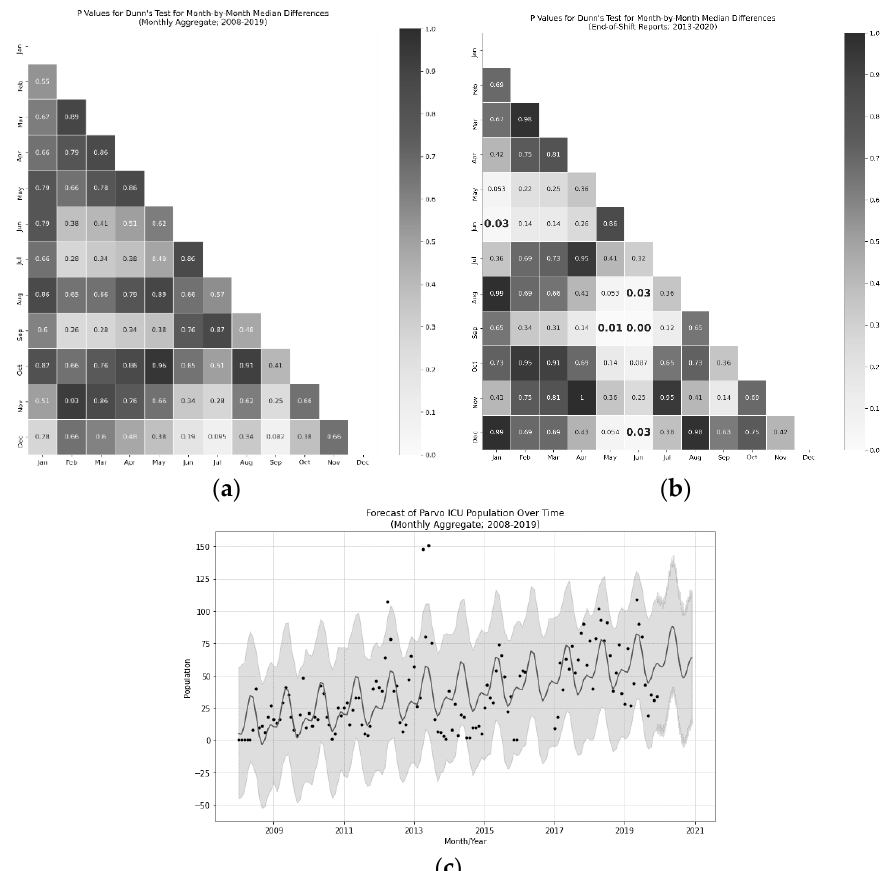
Figure 4. Heatmaps ( a and b ) of Dunn’s test p-values (FDR corrected) for Monthly Aggregate (N = 5127; 2008 – 2019) ( a ) pairwise differences and End-of-Shift Report (N days = 2474; 2013 – 2020) ( b ) pairwise differences from the monthly median canine parvovirus (CPV)-infected population. Bolded elements indicate statistical significance with alpha less than 0.05. Forecast visualization ( c ) from Fourier components model via FBProphet. Peaks can be observed in seasonality in May and June and troughs can be seen in January, August, and September. The overall population of CPV-infected dogs in the ICU increased at a rate of approximately four animals per month with a seasonal component accounting for approximately 41 dogs between peak and trough season.